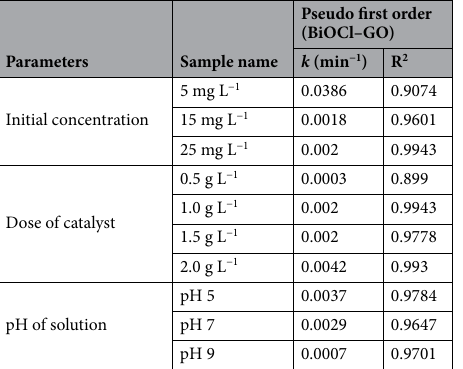
Table 2. The values of k for different mass of BiOCl-GO composite showing inverse relation among rate constant and initial DCF concentration. The results revealed that with the increase in catalyst dose of BiOCl-GO from 0.5 to 2 g L −1 , the apparent rate constant increases from 0.0003 to 0.0042 min -1 , respectively. For varied pH condi- tions the highest rate constant was observed at pH 5 with the value of 0.0037 min −1 . These results suggested that the rate of DCF degradation was higher in acidic condition.